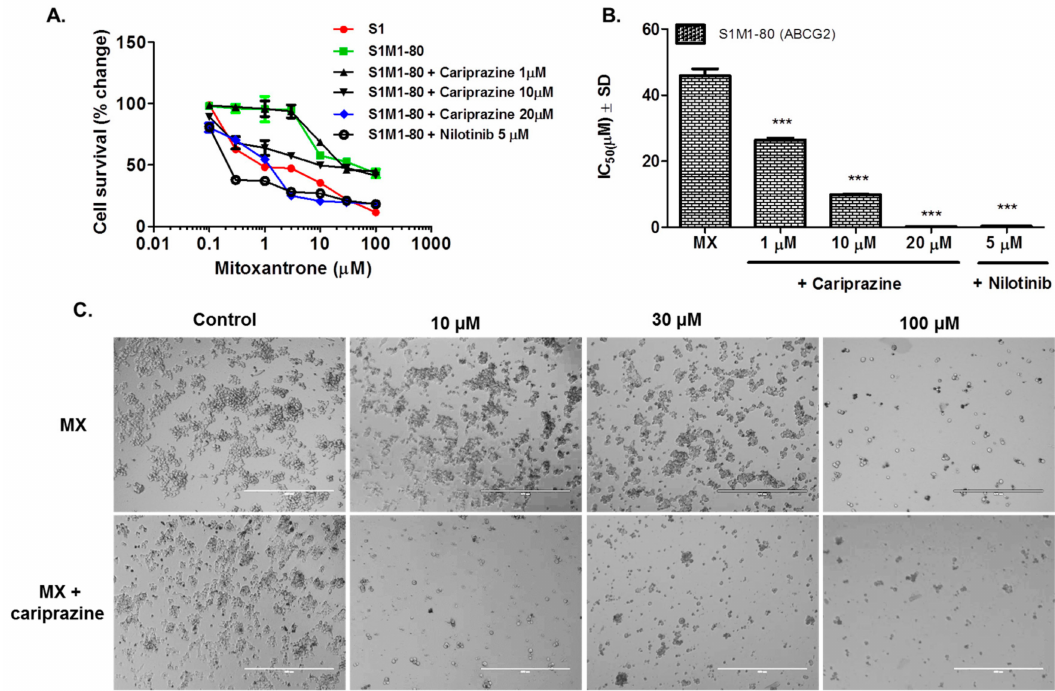
Figure 3. The effect of cariprazine on the efficacy of MX in the ABCG2 overexpressing cell line S1M1-80. ( A ) MTT cytotoxicity is expressed as the percentage change in cell survival. ( B ). The IC 50 values for MX alone (control) or in combination with different concentrations of cariprazine or with 5 µ M of nilotinib in S1M1-80 cells. ( C ) Microscopic images illustrating the synergistic effects of cariprazine on the efficacy of MX at different concentrations. Scale bar: 20 × . The data points represent the means ± SD of at least three independent experiments, each with triplicate determinations. *** p < 0.001 vs. control cells incubated with MX